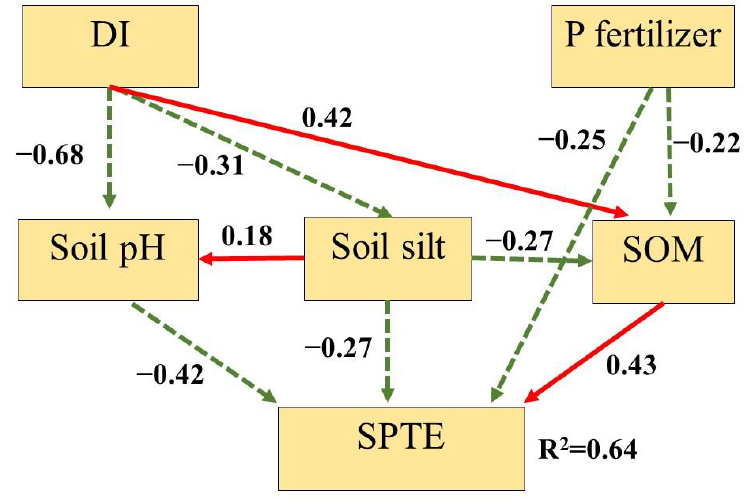
Figure 7. Path analysis results on the direct and indirect effects of DI, soil pH, SOM, soil silt content, and P fertilizer input on SPTE in 91 long-term fertilization experimental sites across Chinese cropping systems (chi/df = 1.36, P = 0.43; RMSEA = 0.05). DI is drought index. The number indicates the path coefficients. The solid and dashed lines indicate significant positive and negative effects, re- spectively.